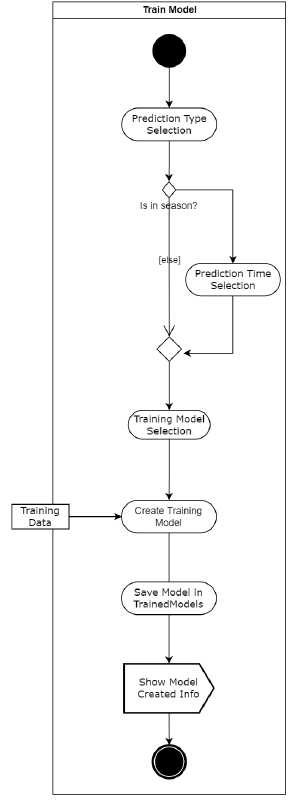
Figure 5. Predict yield.